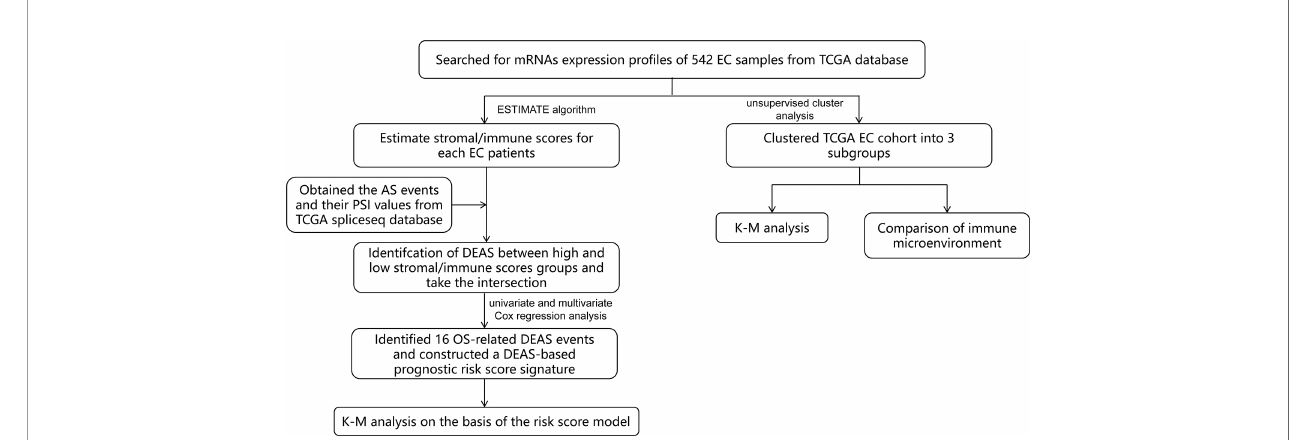
FIGURE 1 | Flow chart of the bioinformatic